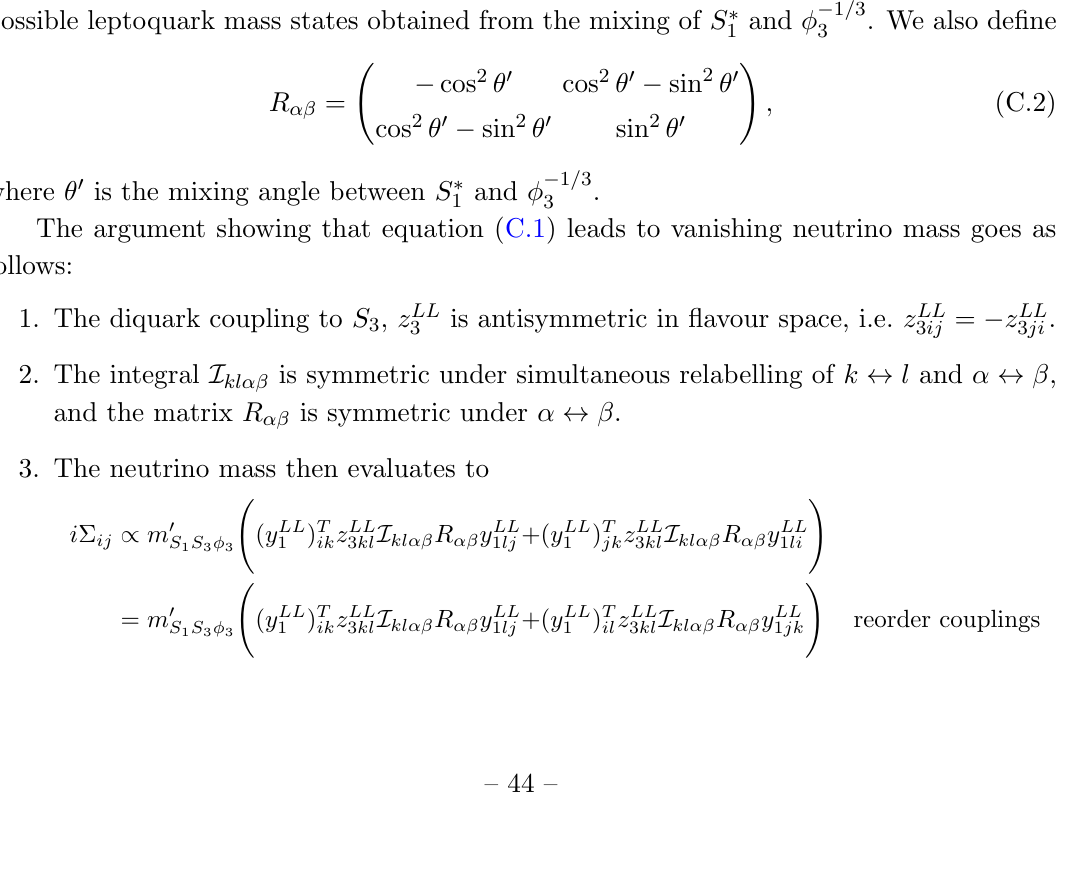
Figure 22 . The UV-completion of operator O 47 by the exotic scalars S 3 (diquark), S 1 (leptoquark) and (cid:30) 3 and its closure forming the neutrino self-energy Feynman diagrams for our model. The leptoquark mass states obtained after mixing are r (cid:11) , for (cid:11) = 1 ; 2 : . equation (B.2), with the k (cid:1) k being suppressed to reduce clutter. The indices k; l 1 2